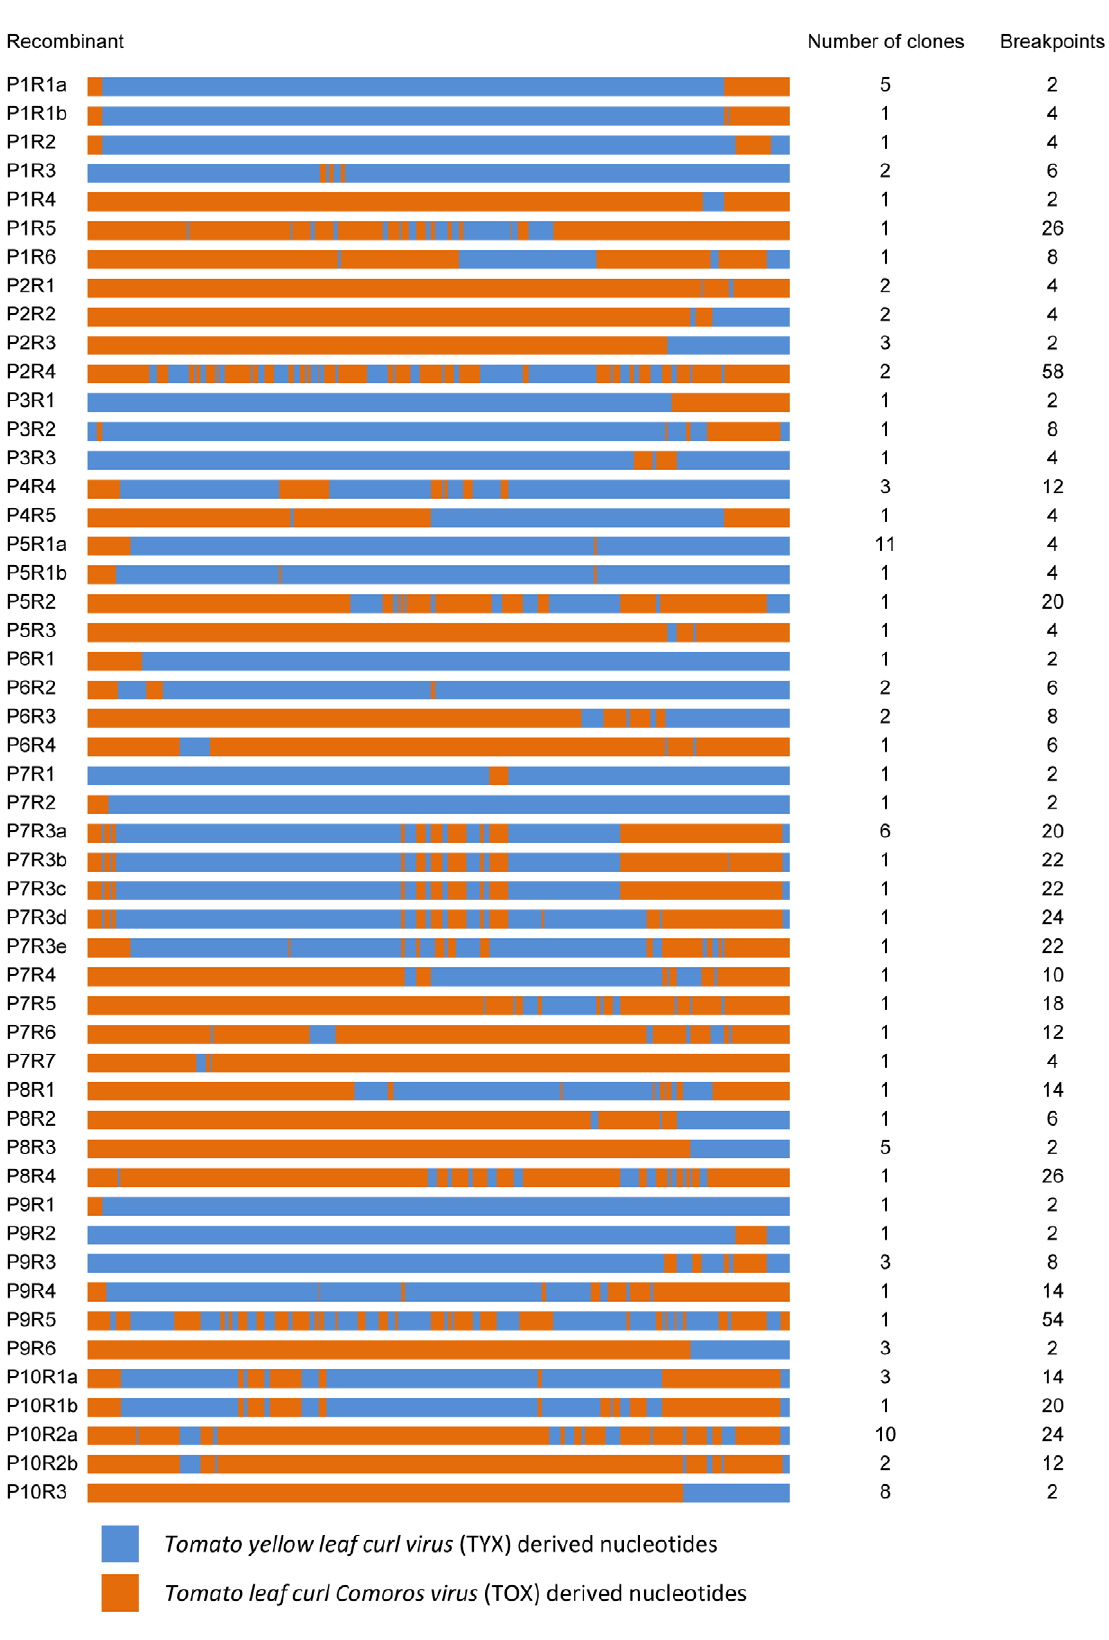
Figure 1. Unique recombinant genome mosaics arising during mixed Tomatoyellowleafcurlvirus (TYX) and TomatoleafcurlComoros virus (TOX) infections. Each line represents one mosaic genome linearized at the virion strand origin of replication. The virus names to the left are in the form P[plant number]R[recombinant number]. Some recombinants are clearly minor variants of the same mosaic structure and are labelled a, b,